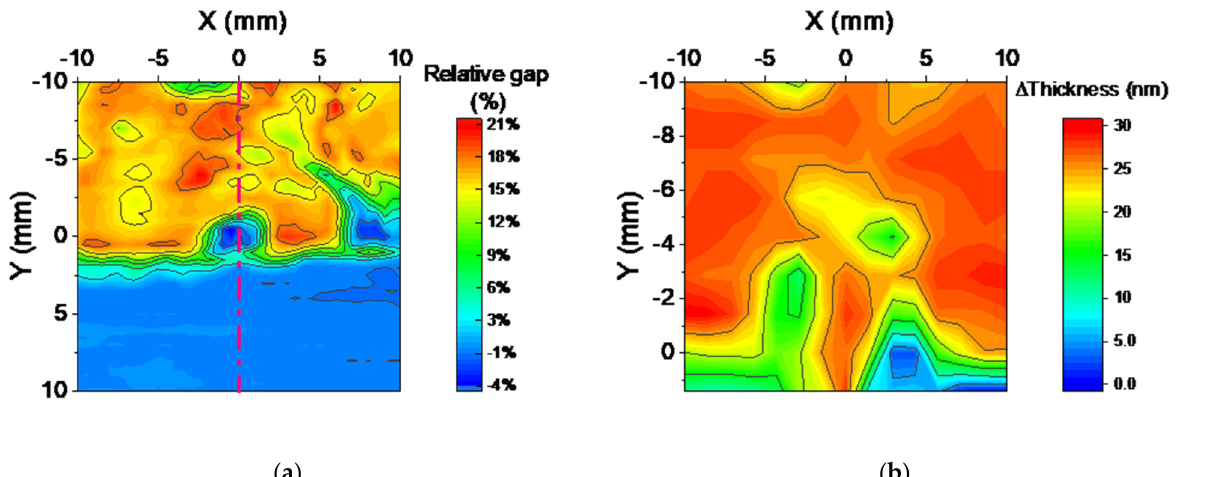
Figure 15. Thickness variations due to the viscosity of the ormosil layer. ( a ) Relative thickness gaps between day 0 and day 38. These gaps are due to the viscosity of the 40 wt.% PDMS-based ormosil thin film. The pink line represents the axis of the study depicted in Figure 17. ( b ) Thickness map of the relative thickness gaps between day 0 and day 38.